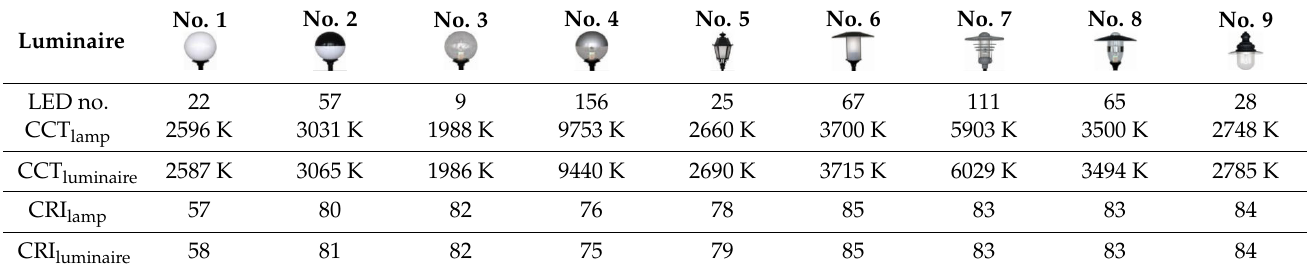
Table 7. The LED sources together with the CCT and CRI values, for which the LP values are similar and equal to 141%.